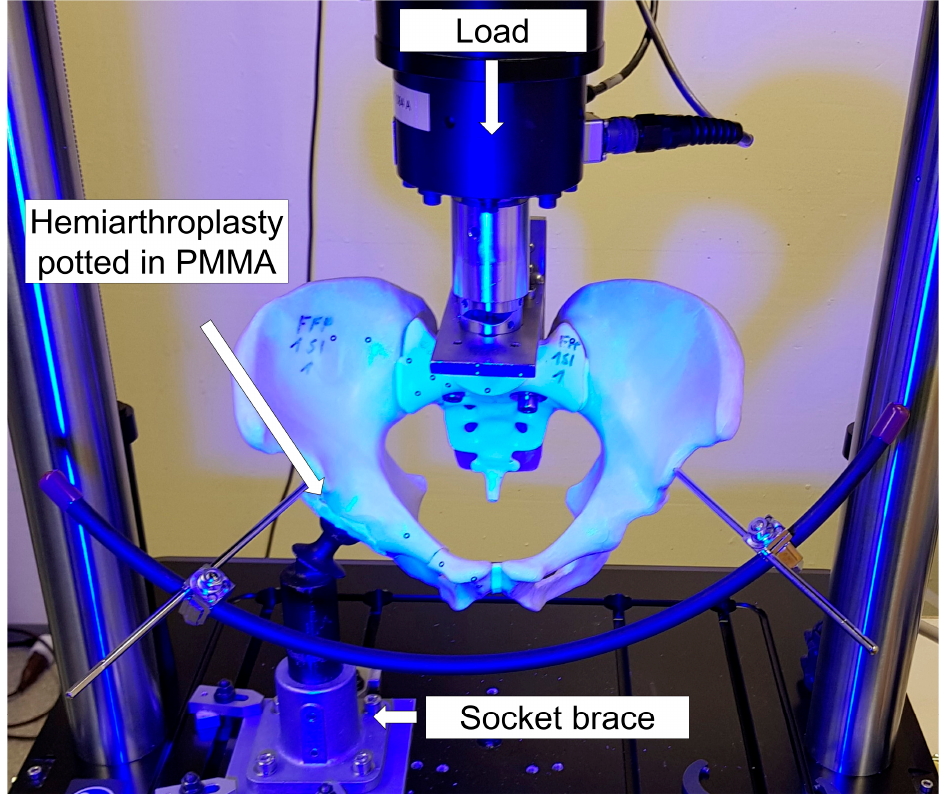
Figure 4. Setup with a specimen mounted for biomechanical testing in one-legged stance